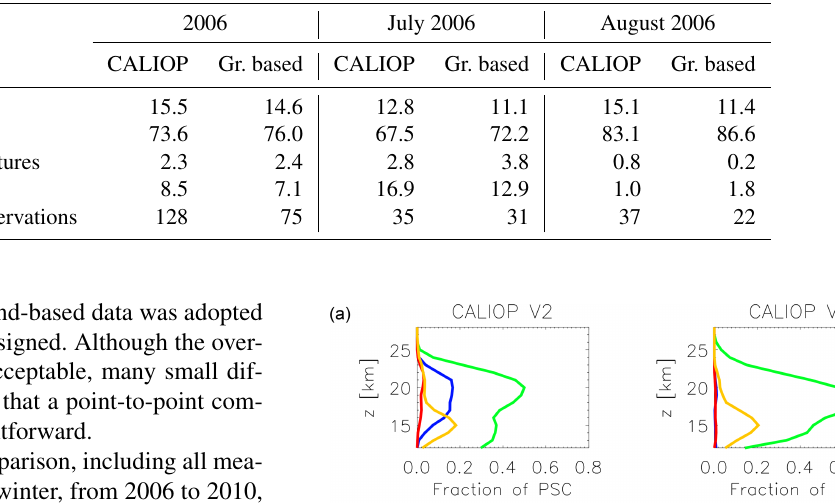
Table 2. Frequency of occurrence (in %) of PSC classes for 2006 and for July and August separately. The last line represents the number of overpasses in the McMurdo box for CALIOP and the number of ground-based observations. Observations in the 12–30km interval have been considered. The ice-class for CALIOP also includes mountain wave ice.